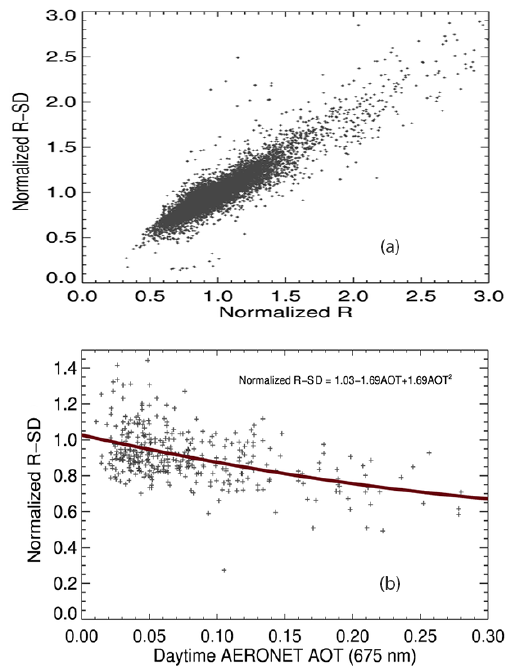
Figure 5. (a) Normalized radiance versus normalized standard de- viation of radiance for 200 cities over the US for 2015. (b) The normalized standard deviation of radiance as a function of adjacent daytime AERONET AOT